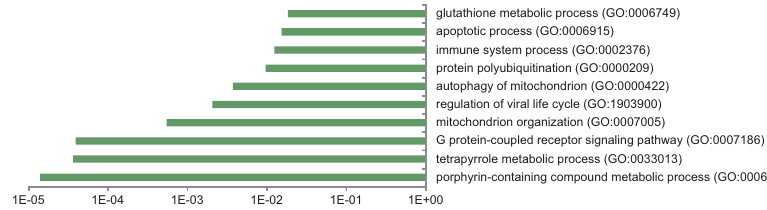
Fig. 3 PANTHER Gene Ontology analysis of the AIWG-P gene set. Shown are terms with q < 0.05; full numerical data are provided in Supplementary fi le section 3. No signi fi cantly overrepresentation terms were identi fi ed in the AIWG-R gene